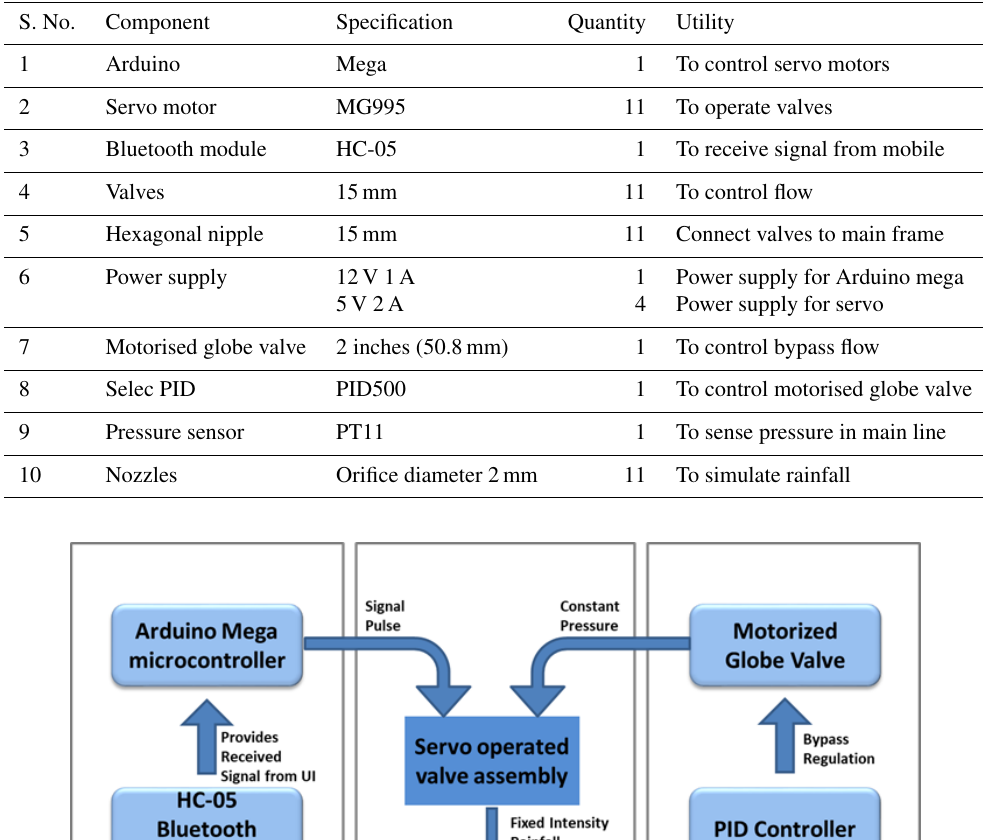
Table 1. Specification of components used for moving storm rainfall simulator.